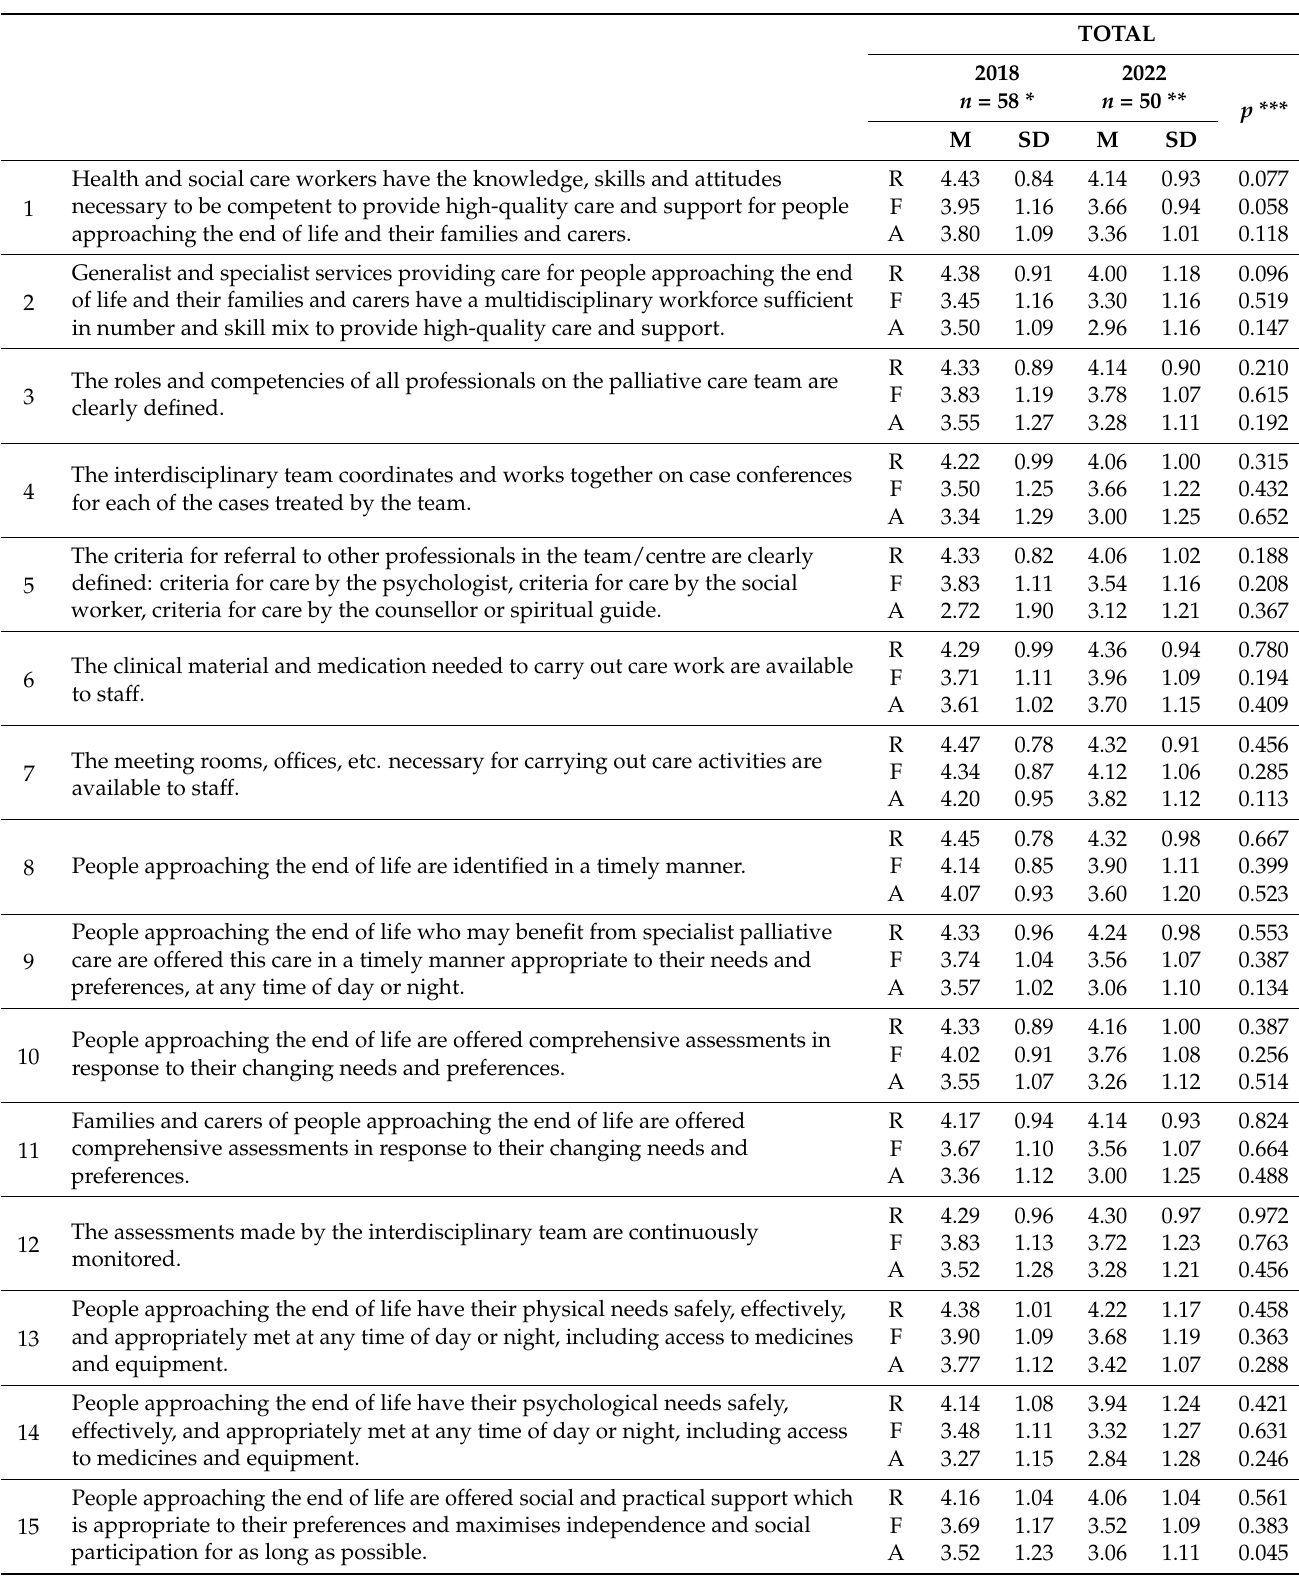
Table 2. Differences in scores given by all participants between 2018 and 2022, according to relevance, feasibility and level of